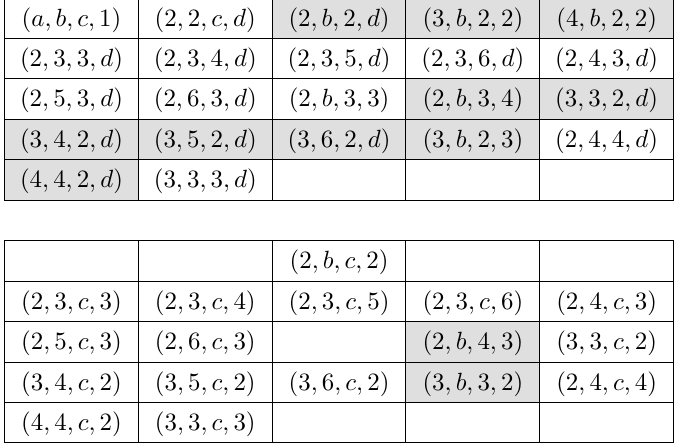
Table 5 . Infinite sequences of type II singularities. The reducible cases are marked in gray. The lower table is obtained from the upper table by exchanging c and d , and the empty entries are either symmetric under exchange or have c = 1 . This table is adapted from